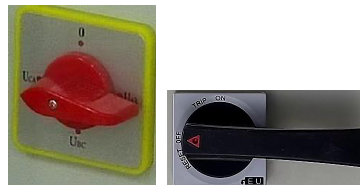
Figure 10. YOLOv4 knob areas positioning results.